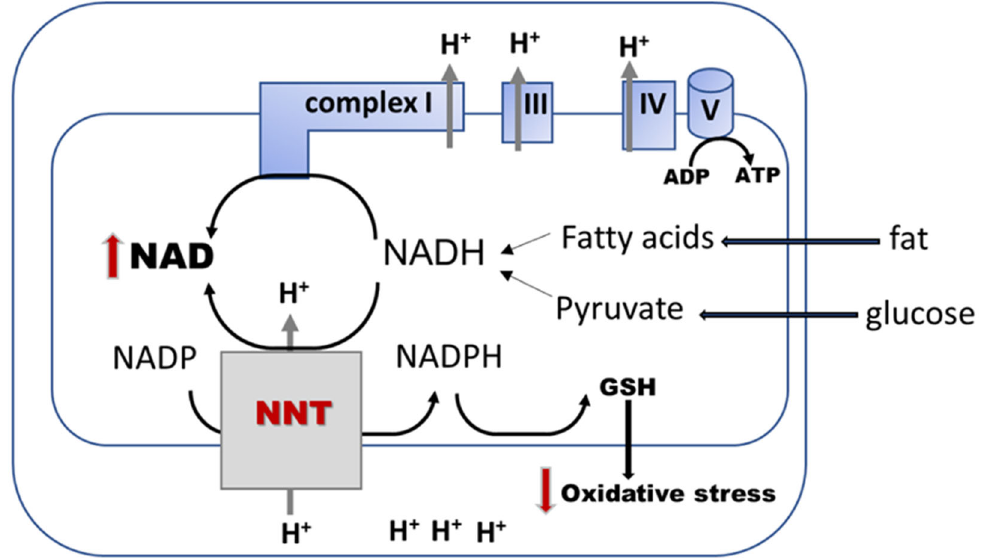
Figure 4. The role of nicotinamide nucleotide transhydrogenase (NNT) in decreasing the reductive and oxidative stress. NNT is an inner mitochondrial membrane enzyme that transfers electrons from mitochondrial NADH to NADPH by using the inner membrane proton motive force to boost the peroxide antioxidant defense, such as reduced glutathione (GSH) [186,187]. The enzyme reduces NADPH by oxidizing NADH that is generated by oxidizing energetic substrates (i.e., fat and glucose), thus decreasing the reductive stress (NADH/NAD ratio).